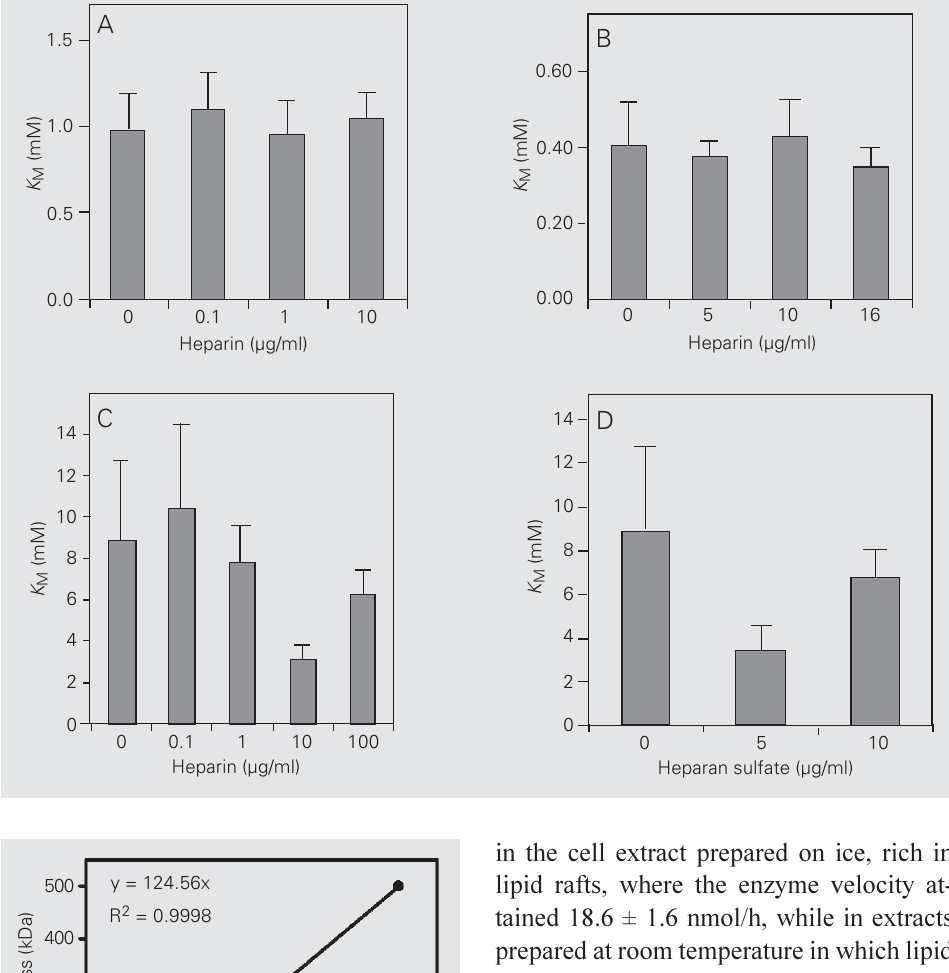
Figure 4. Determination of K M for DPP-IV (CD26) in the pres- ence of heparin or heparan sul- fate. A , DPP-IV associated with S17 cell membranes in the pres- ence of heparin (0 to 10 µg/ml). B , DPP-IV purified from porcine kidney (Sigma) in the presence of heparin (0 to 16 µg/ml). C , DPP-IV in the supernatant of S17 cell cultures in the presence of heparin (0 to 100 µg/ml). D , DPP- IV in the supernatant of S17 cell cultures in the presence of hep- aran sulfate (0 to 10 µg/ml).